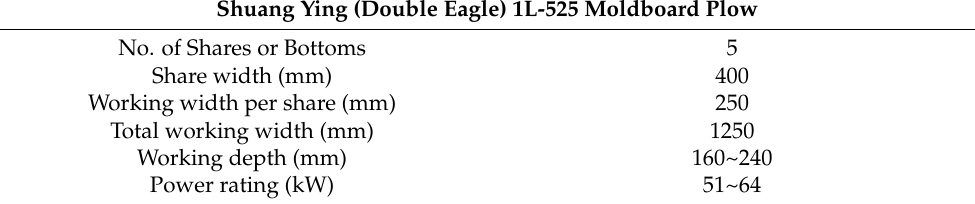
Table 4. Moldboard plow specifications.